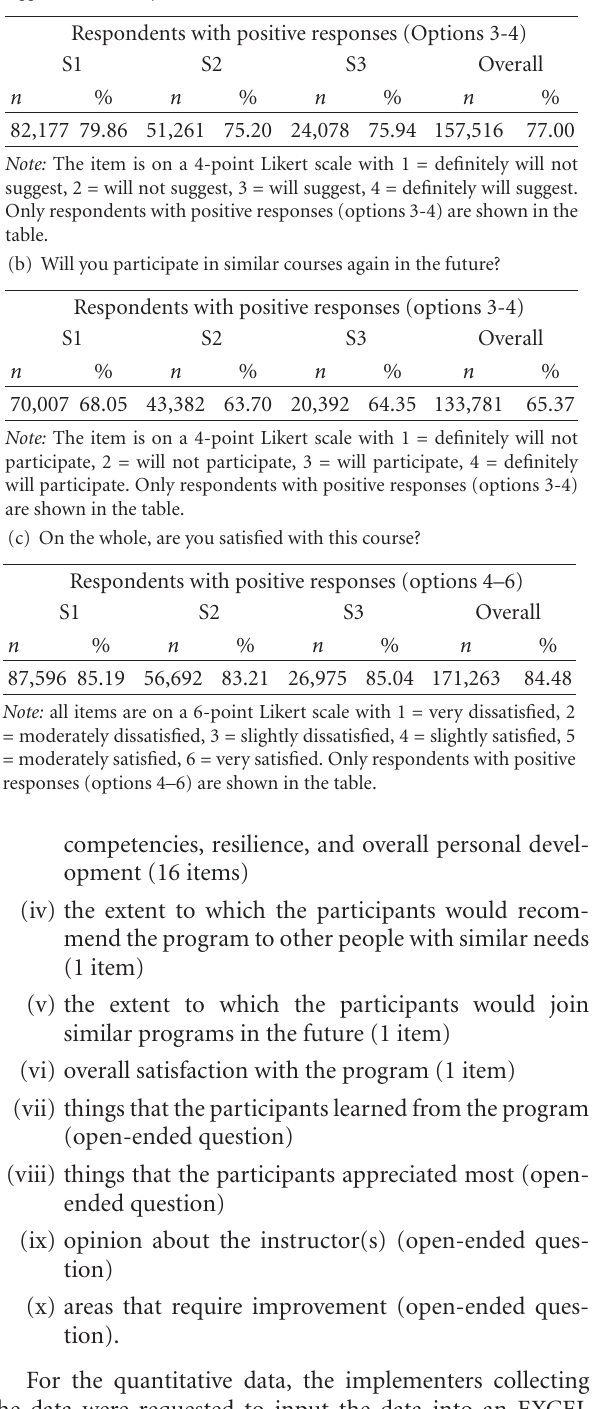
Table 5: Other aspects of subjective outcome evaluation based on the program participants’